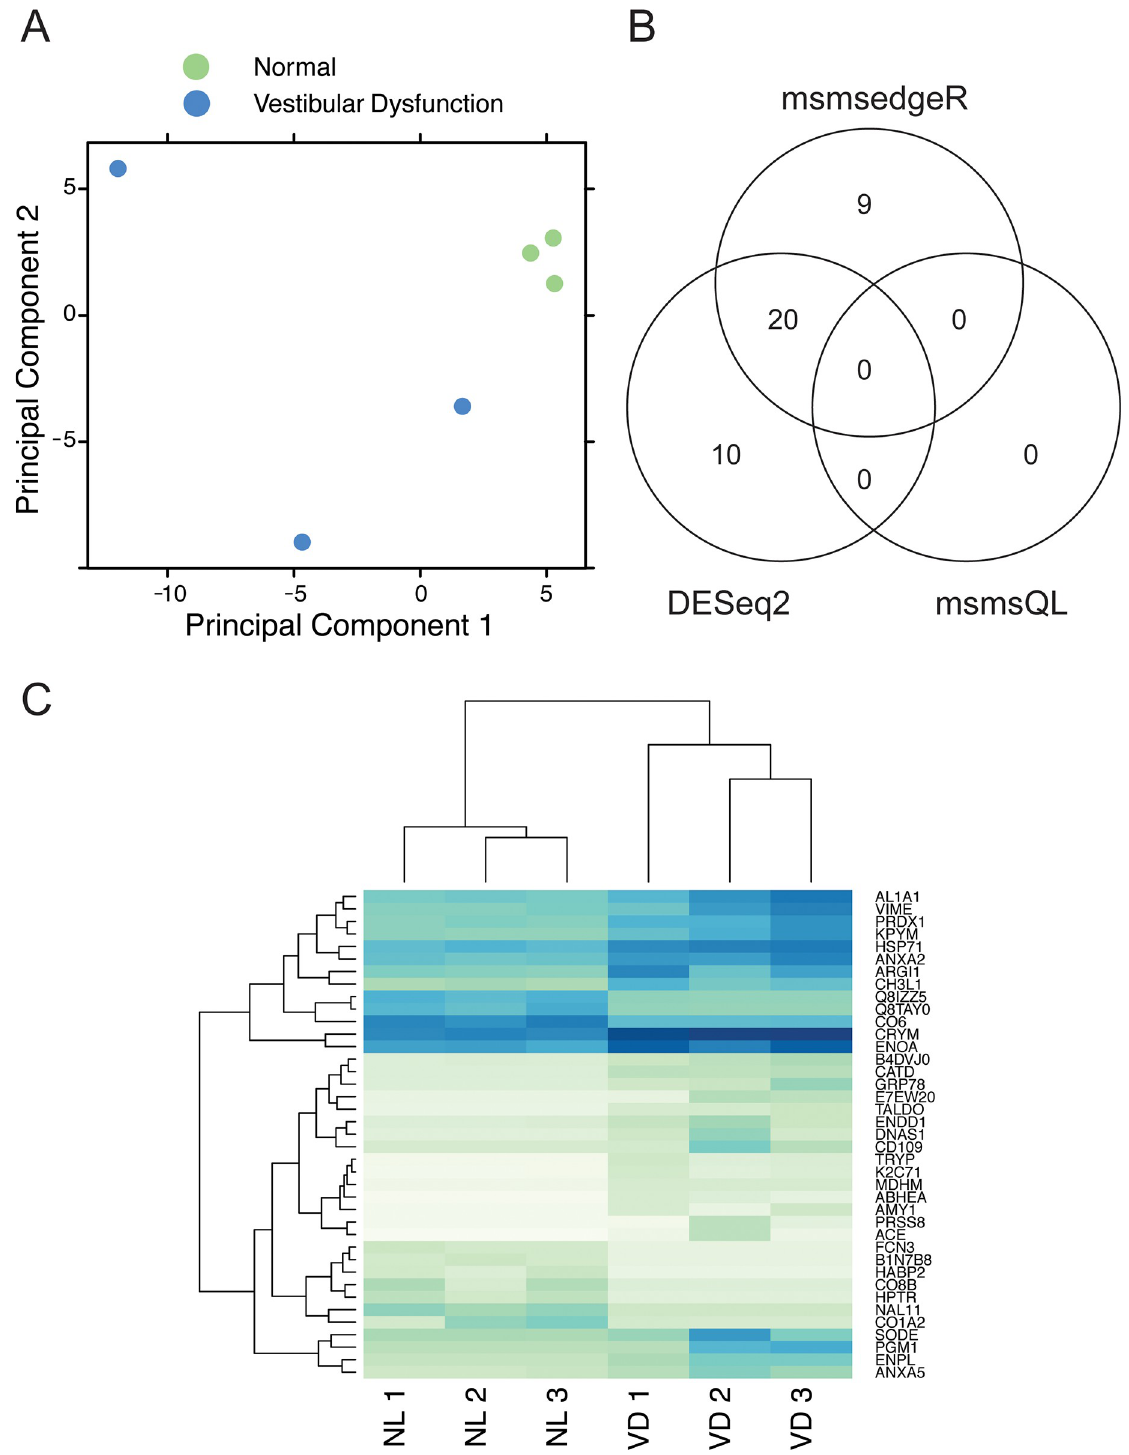
Fig 2. Proteomic analysis of human perilymph. ( A ) Principal component analysis (PCA) of the normalized and log-transformed spectral count matrix from the 6 samples of perilymph, including 3 from patients with normal hearing (pseudocolored green) and 3 from patients with severe vestibular dysfunction (pseudocolored blue). Tight clustering is observed among the clinically normal samples but the vestibular dysfunction samples appear quite heterogeneous. (B) Venn diagram of differentially expressed proteins identified by each differential expression analysis approach (DESeq2, msmsedgeR and msmsQL). (C) Heat map of proteins differentially expressed between